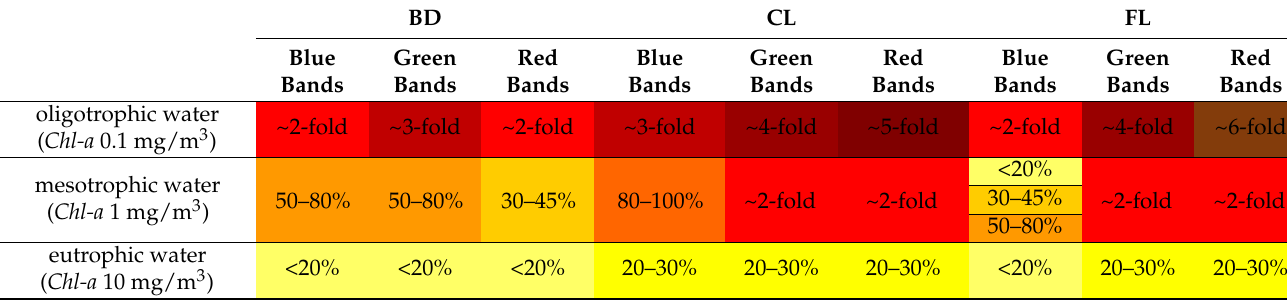
Table 1. Color scale illustration of the increase of R rs in three typically considered spectral bands of visible light obtained through radiative transfer modeling for three types of ocean waters and three kinds of dispersed oils. Blue bands: 400–510 nm, green bands: 510–590 nm, red bands: 590–700